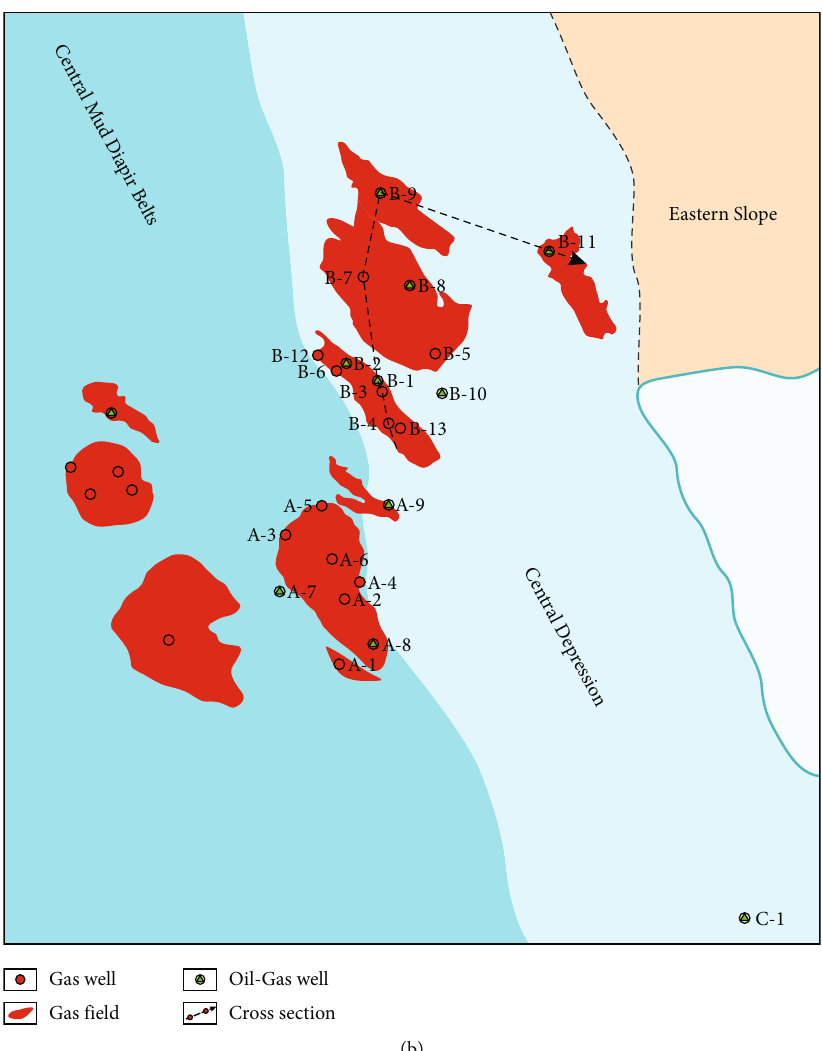
Figure 1: (a) Simpli fi ed structural map of the Yinggehai Basin and the study area, and (b) the distribution of wells in the LD-B